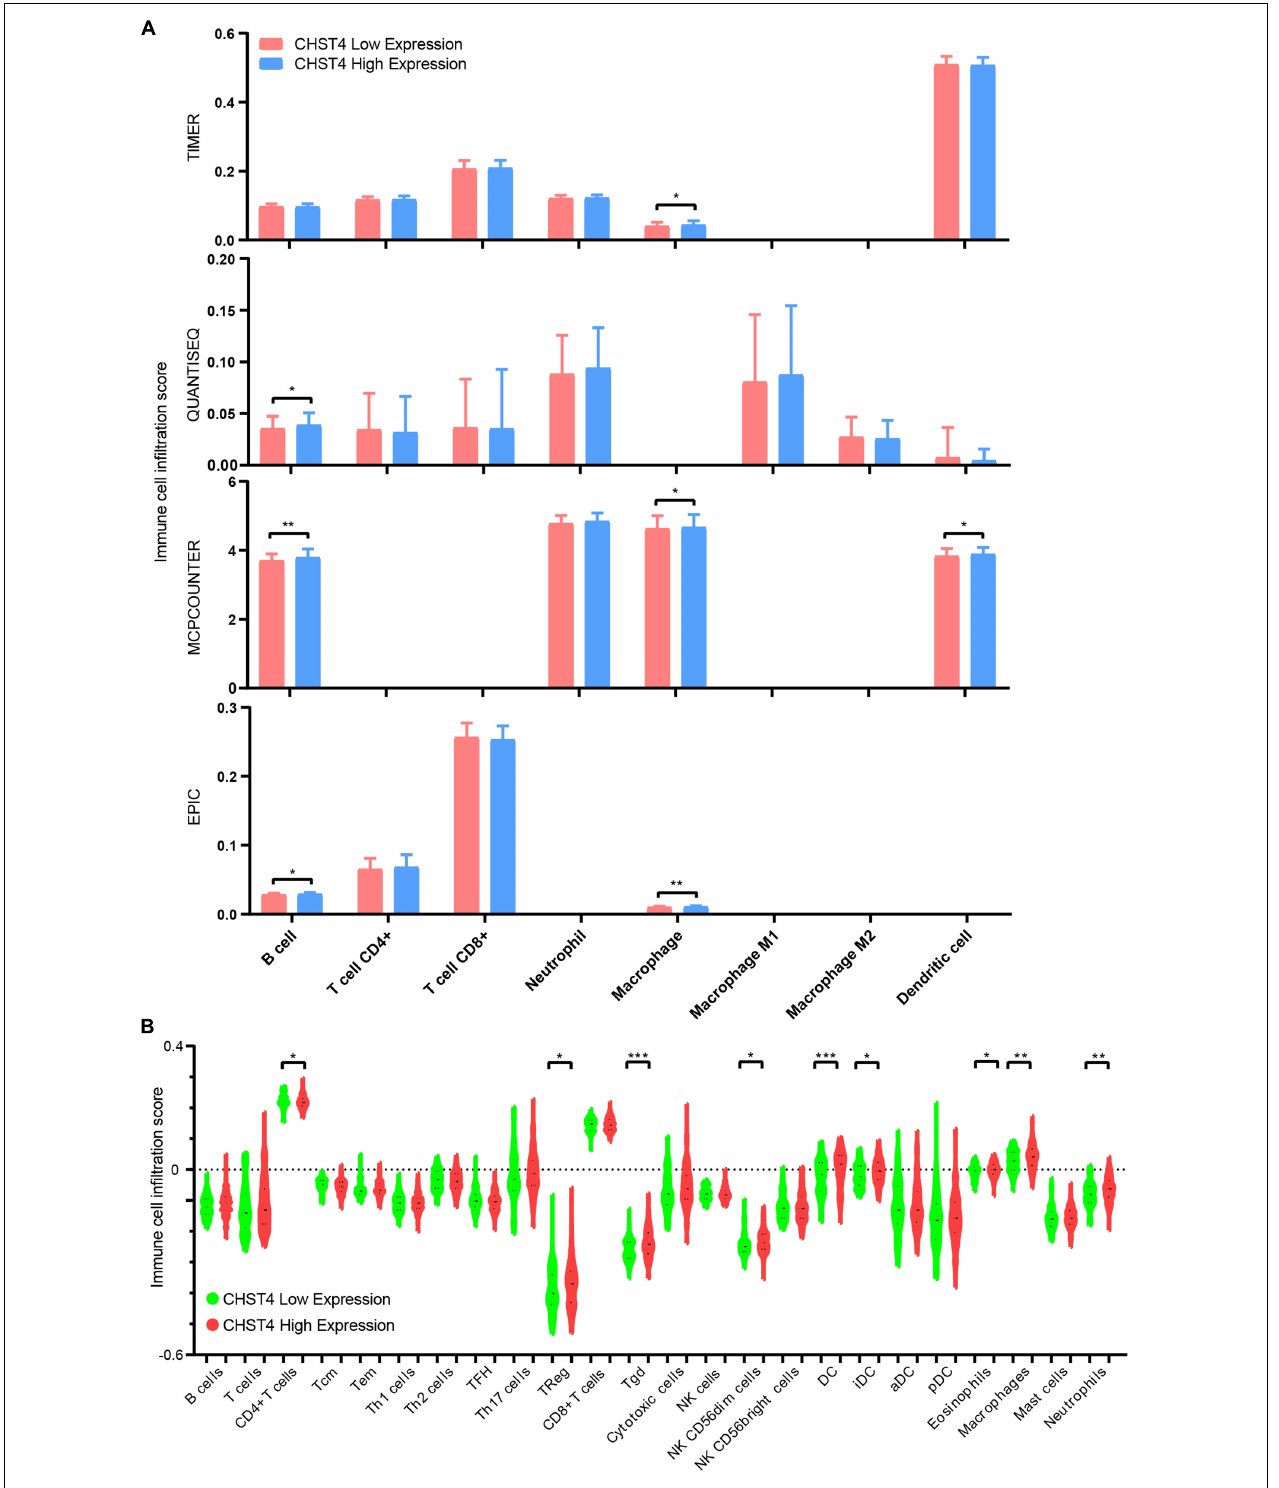
FIGURE 8 | The correlation between CHST4 and immune cell infiltration in HBV-HCC. (A) The degree of immune infiltration in HBV-HCC was evaluated by TIMER platform (TIMER, QUANTISEQ, MCPCOUNTER, and EPIC databases). Bar represents the mean ± SD; * P < 0.05, ** P < 0.01 (Student’s t -test). (B) The immune cell infiltration score in HBV-HCC using R-ssGSEA (Tcm, T central memory cells; Tem, T effector memory cells; Th1 cells, T helper 1 cells; Th2 cells, T helper 2 cells; TFH, T follicular helper cells; Th17 cells, T helper 17 cells; Treg, regulatory T cells; Tgd, T gamma delta cells; NK cells, natural killer cells; DC, dendritic cell; iDC, immature DC; aDC, activated DC; pDC, plasmacytoid DC). Bars represent the mean ± SD; * P < 0.05, ** P < 0.01, *** P < 0.001 (Student’s t -test).